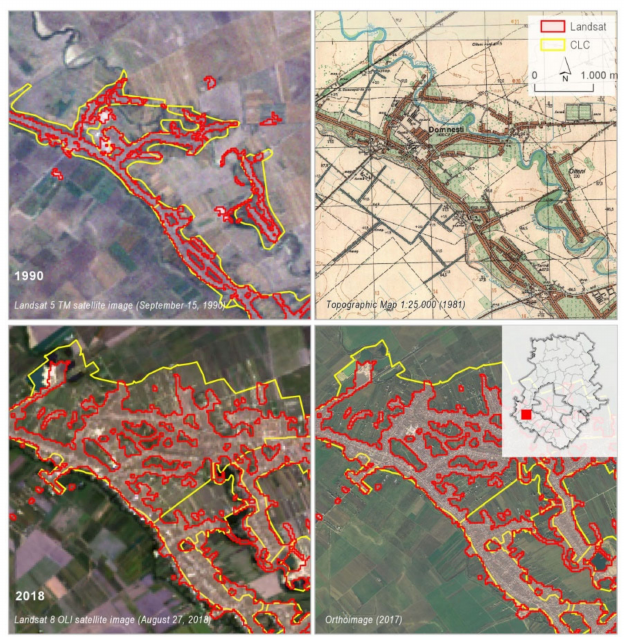
Figure 10. Comparative mapping of the change in the built-up area (1990 / 2018) in Domnes the west of Bucharest. Landsat TM (1990) and OLI (2018) imagery from USGS, topographic map (1981) from the DTM (Military Topographical Directorate) and aerial orthophotos (2017) by ANCPI (National Agency of Cadastre and Land